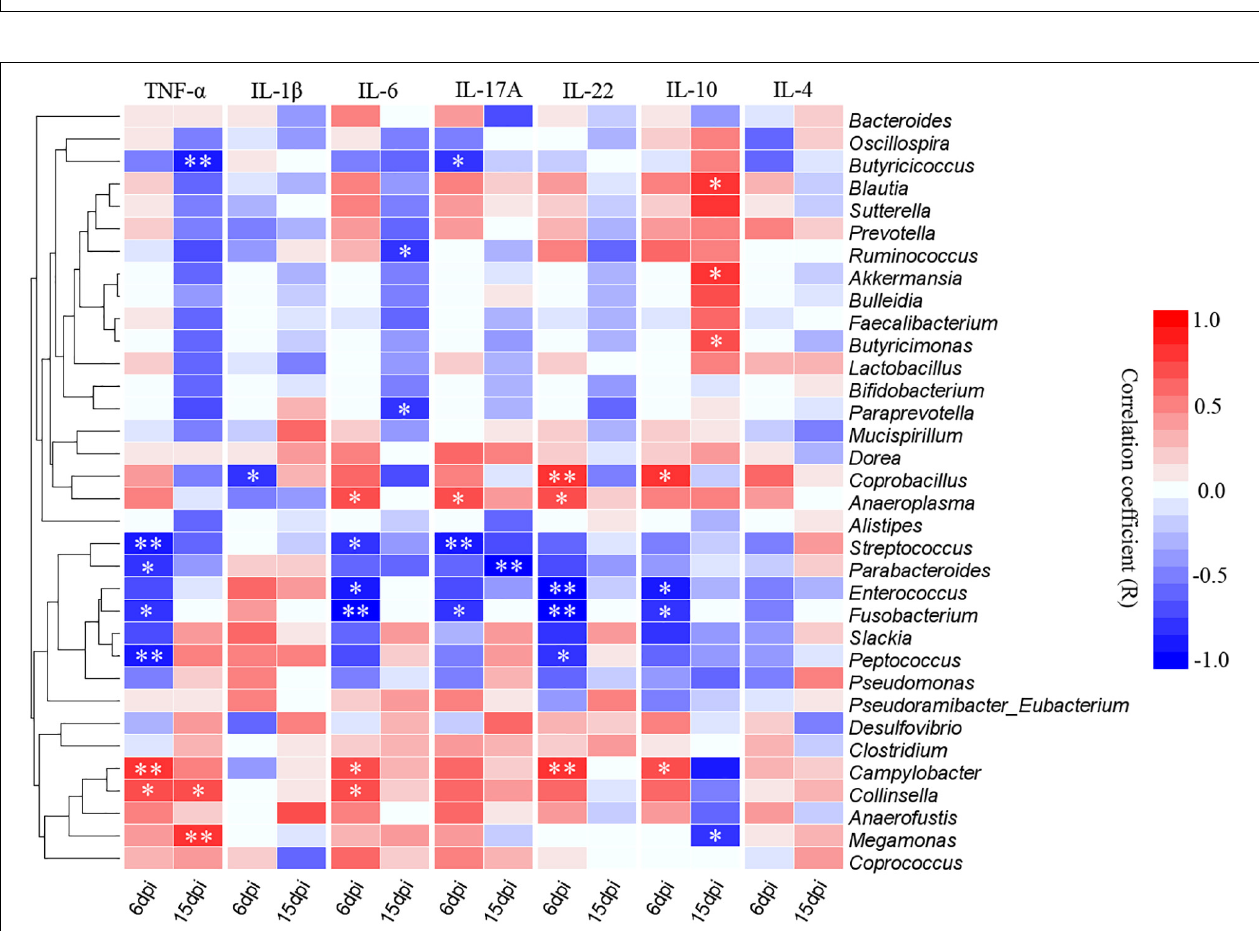
FIGURE 9 | Correlogram showing Spearman’s correlations between bacterial genera and cytokine responses in the caecum. Heatmap representing positive (blue shading) and negative (red shading) associations between pro-inflammatory TNF- α , IL-1 β , IL-6, IL-17A, and IL-22 and anti-inflammatory IL-10 and IL-4. Only the predominant bacterial genera (relative abundance ≥ 0.01% in every sample at least one group) for which abundance was significantly associated with inflammatory cytokines expression are presented; Clustering was performed based on genera associations with the inflammatory cytokines. P -values were adjusted for false discovery rate according to Bonferroni and Hochberg procedure. An asterisk indicates a significance correlation between the bacterial taxa and the cytokine in a tissue ( ∗∗ P < 0.01, ∗ P < 0.05).